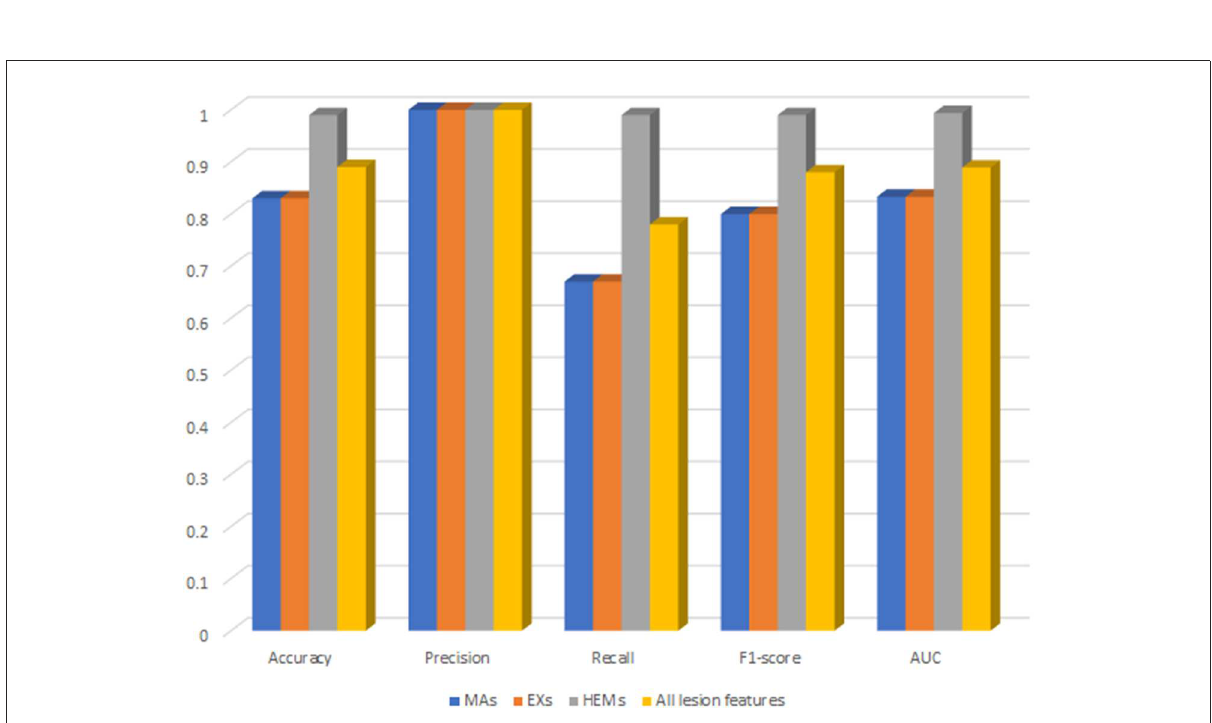
FIGURE4 The performance of XGBoost with each type of lesion features as well as their